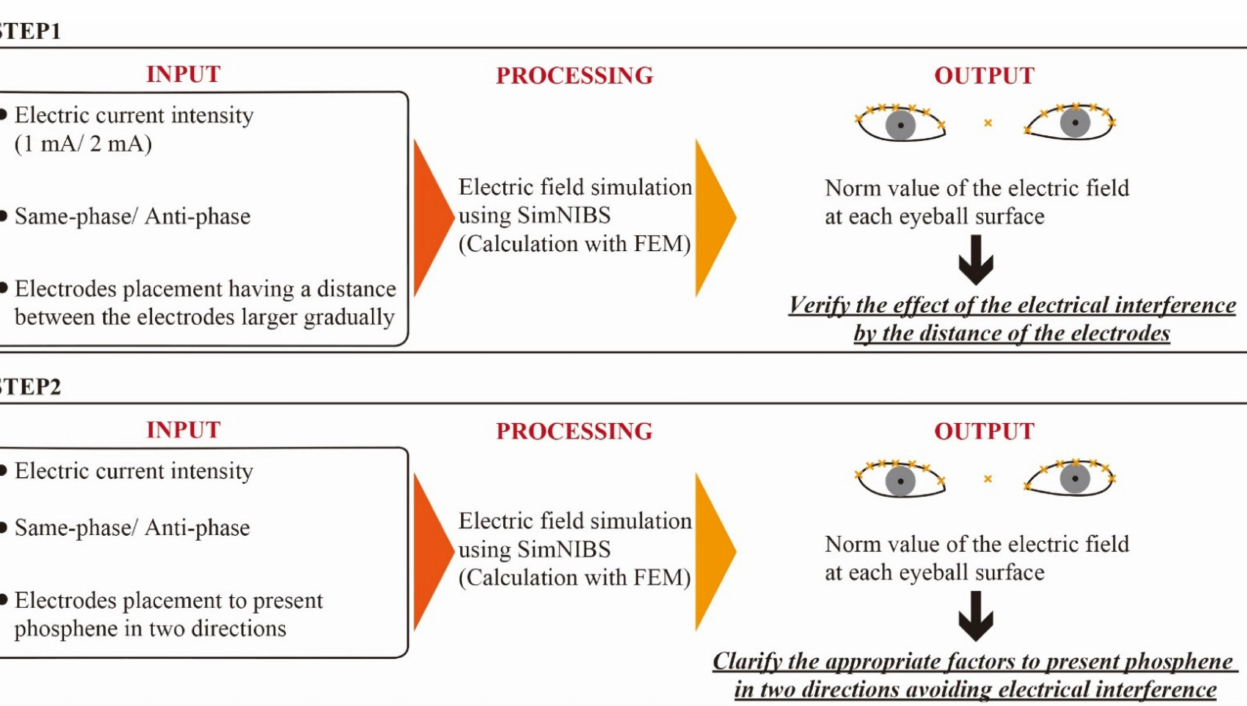
Figure 6. Diagram of the evaluation method for avoiding the electric interference while presenting phosphene in two